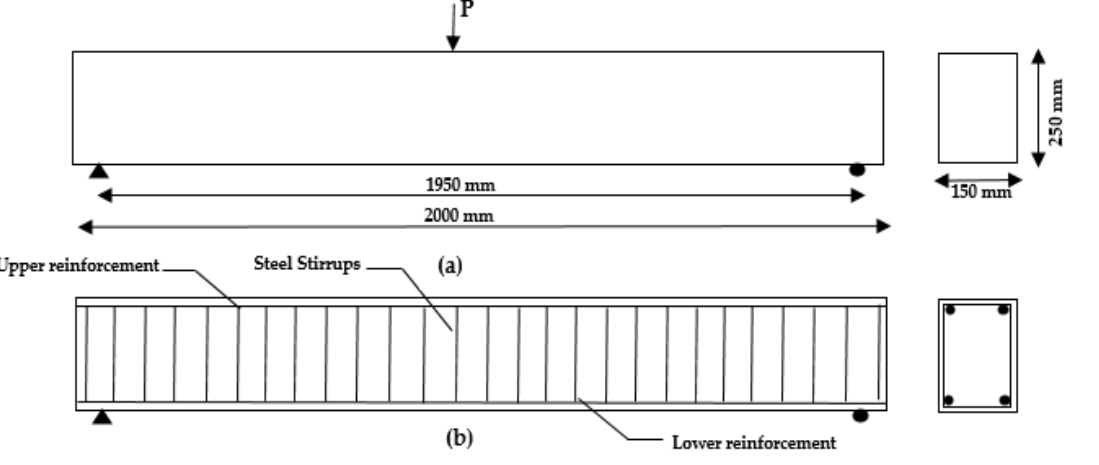
Figure 4. Details of concrete beams: ( a ) concrete dimensions of simple beam and ( b ) longitudinal reinforcement configuration.